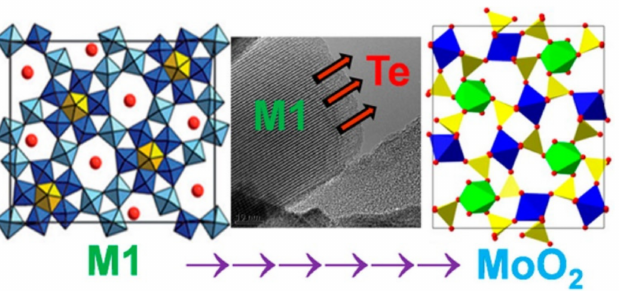
Figure 5. Te sublimation from the M1 phase under severe reaction conditions converts to the MoO 2 phase. Adapted from ref. [45], Copyright (2014), with permission from the American Chemical Society.